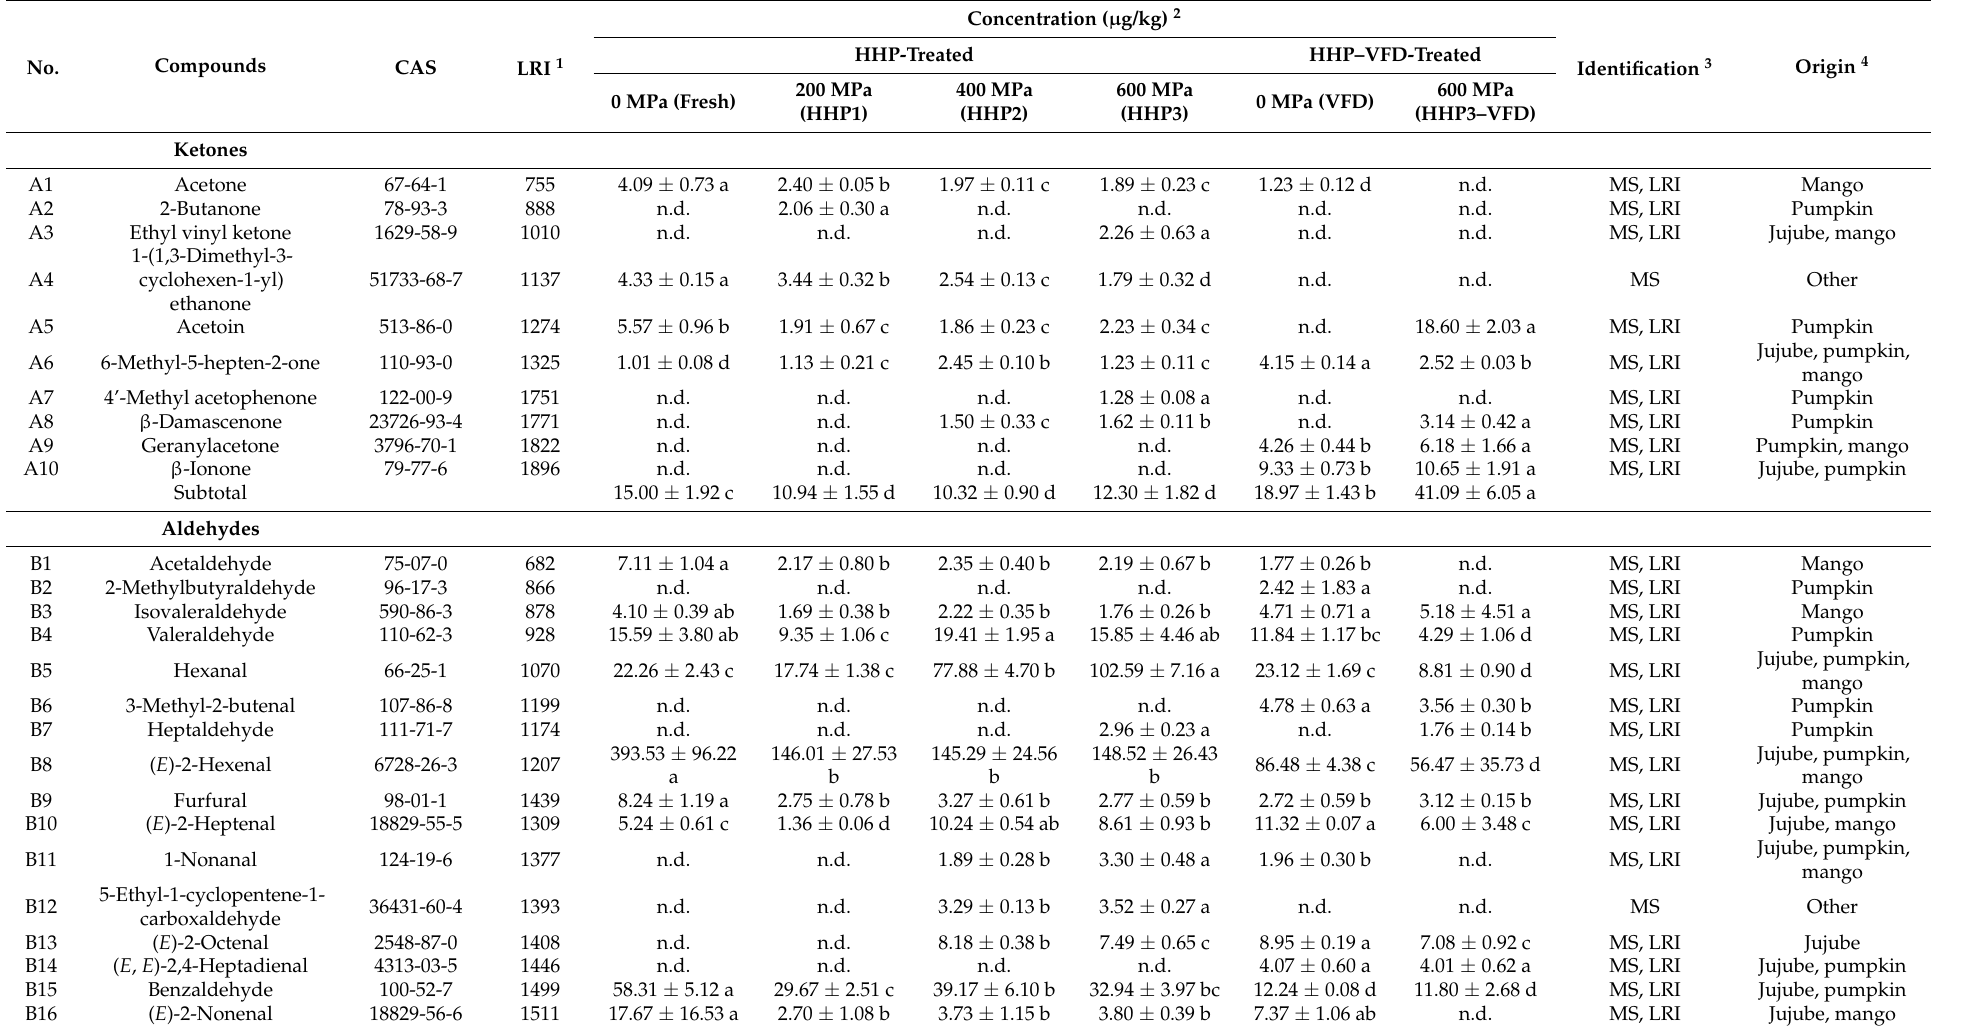
Table 2. Volatile compounds in blended juices treated by HHP and VFD recognized by